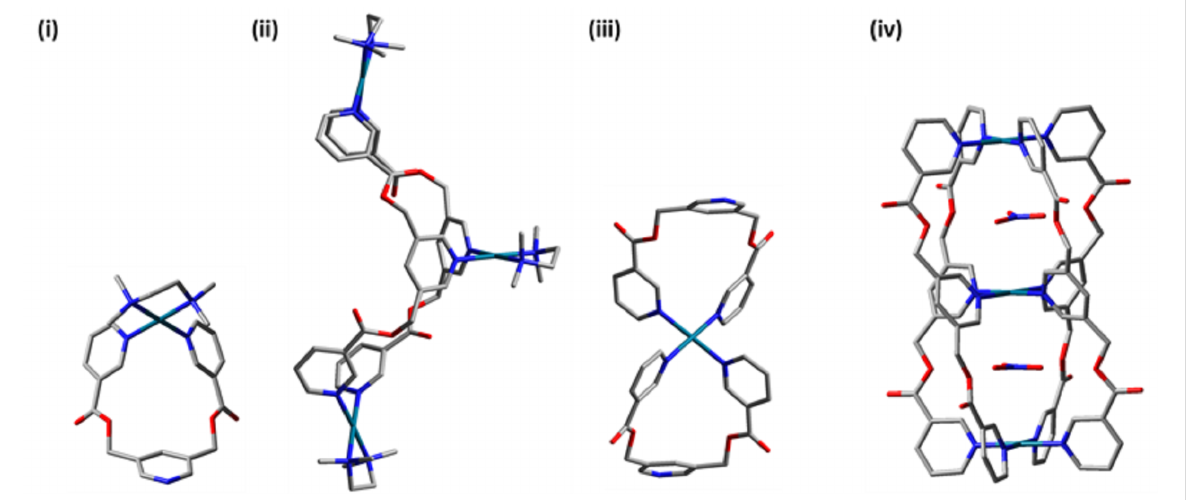
Figure 4: Energy-minimized structures of (i) [Pd(tmeda)( L1 )] 2+ , (ii) [Pd 3 (tmeda) 3 ( L1 ) 2 ] 6+ , (iii) [Pd( L1 ) 2 ] 2+ , and (iv) [(NO 3 ) 2 @Pd 3 ( L1 ) 4 ] 4+ . Hydrogen atoms are omitted for clarity, red, blue, grey and cyan colors represent oxygen, nitrogen, carbon and palladium, respectively.